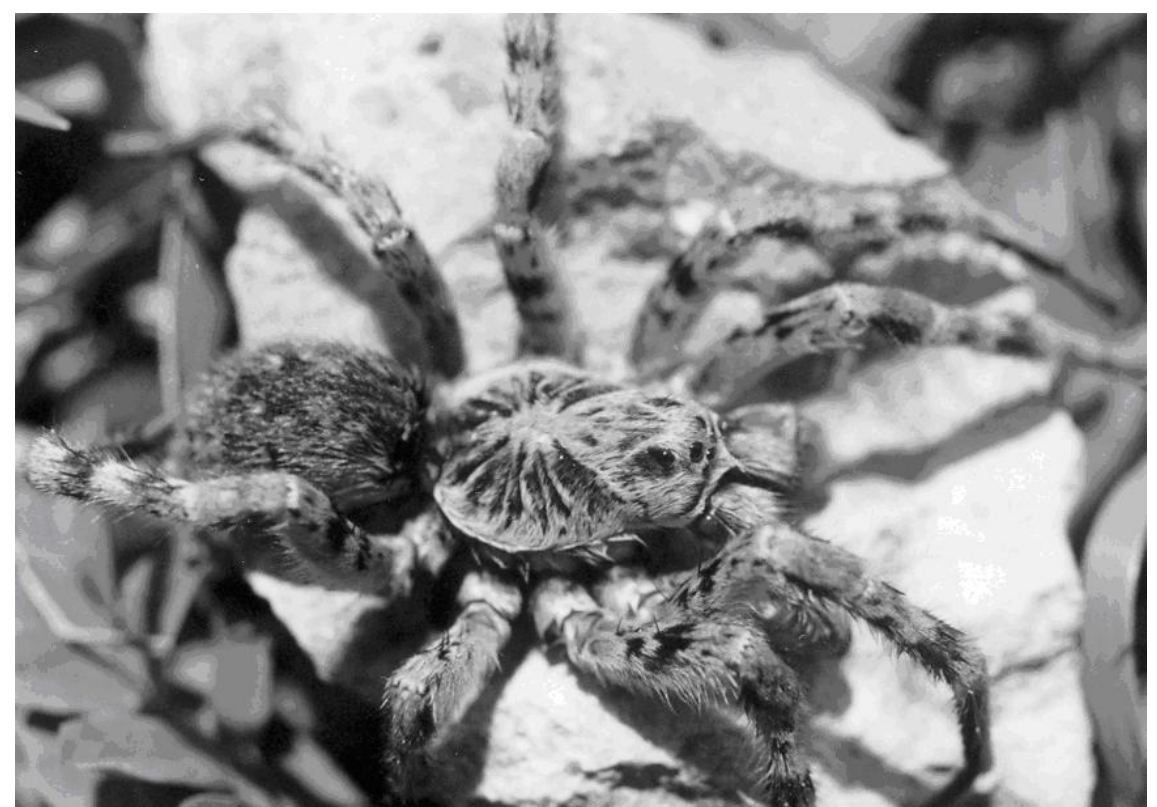
Figure 1. Female L. singoriensi s.